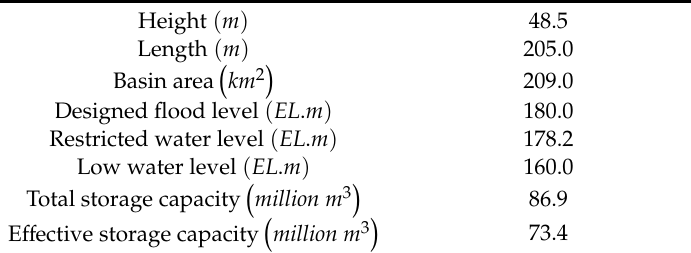
Table 1. Specifications of the Hoengseong multi-purpose dam.